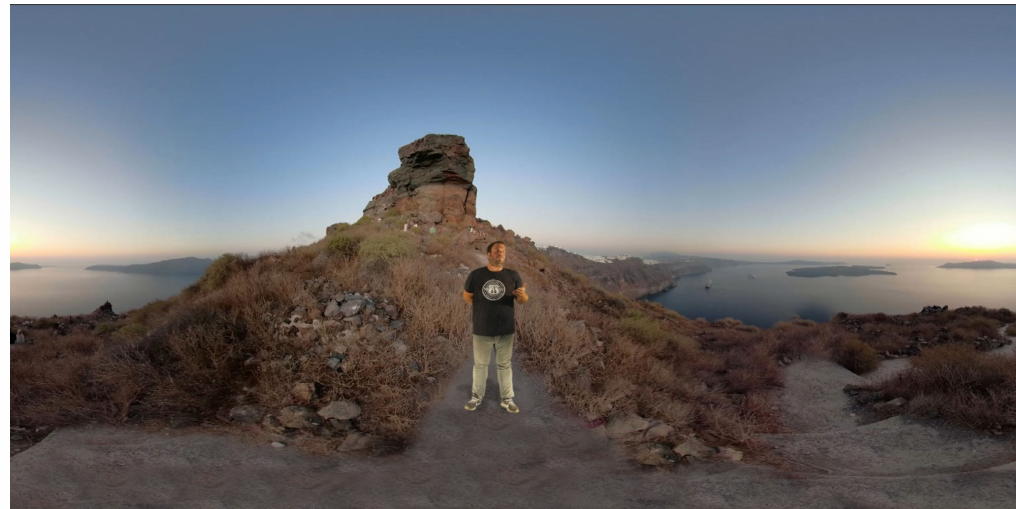
Figure 17. Guided tour by an expert—Green Screen 360 ◦ video production with a narrator (credits to Alexandros Arapantonis).